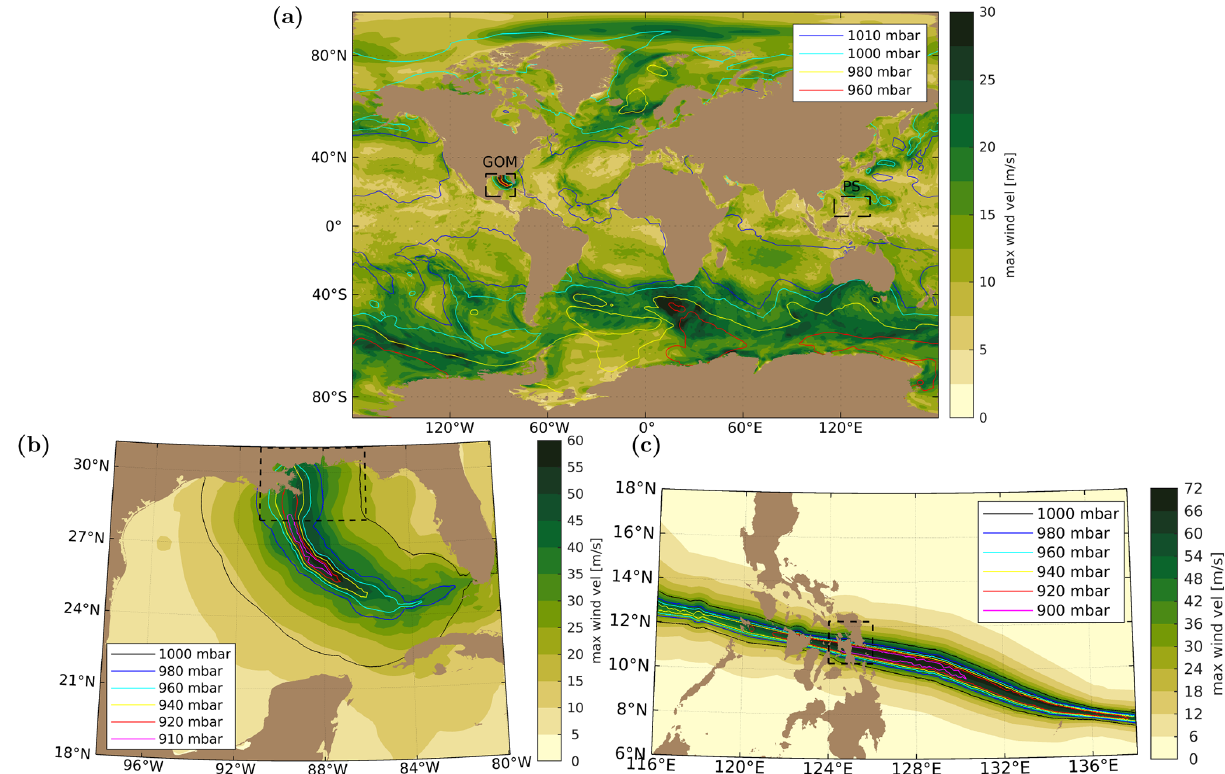
Figure 4. Maximum 10m wind velocities and minimum pressure contours over the ocean for Hurricane Katrina (25–31 August 2005) and Super Typhoon Haiyan (4–10 November 2013). (a) Global view displaying CFSR reanalysis data during Katrina except in the Gulf of Mexico region (indicated by the black dashed box labeled GOM); (b) Gulf of Mexico region displaying OWI reanalysis data of Katrina; (c) Philippine Sea region (indicated by the black dashed box labeled PS in panel a ) displaying the best-track Holland parametric vortex model of Haiyan. Black dashed boxes in (b) and (c) indicate the landfall regions where the mesh is locally refined for each storm. Table 3. RMSE t (cm; see Appendix A) values for simulated tidal results using ADCIRC v55 (upgrade) and ADCIRC v54 in deep ( h > 1km) and shallow ( h < 1km) waters on the Ref mesh. Results from other forward barotropic tidal models (Stammer et al., 2014; Ngodock et al., 2016; Schindelegger et al., 2018; Lyard et al., 2020) are included for comparison where known. M 2 RMSE t (cm) RMSE t | tot (cm) Model Latitudes Deep water Shallow water Deep water Shallow water